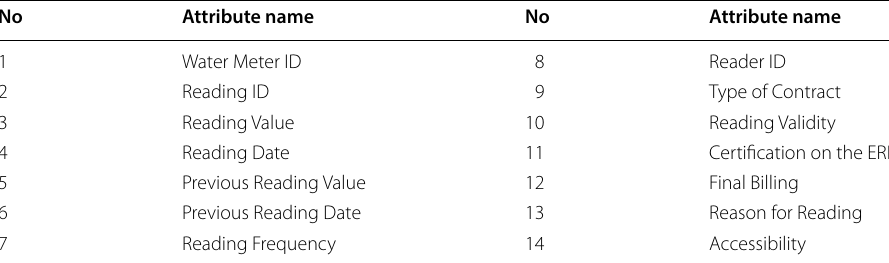
Table 1 Reading dataset attributes